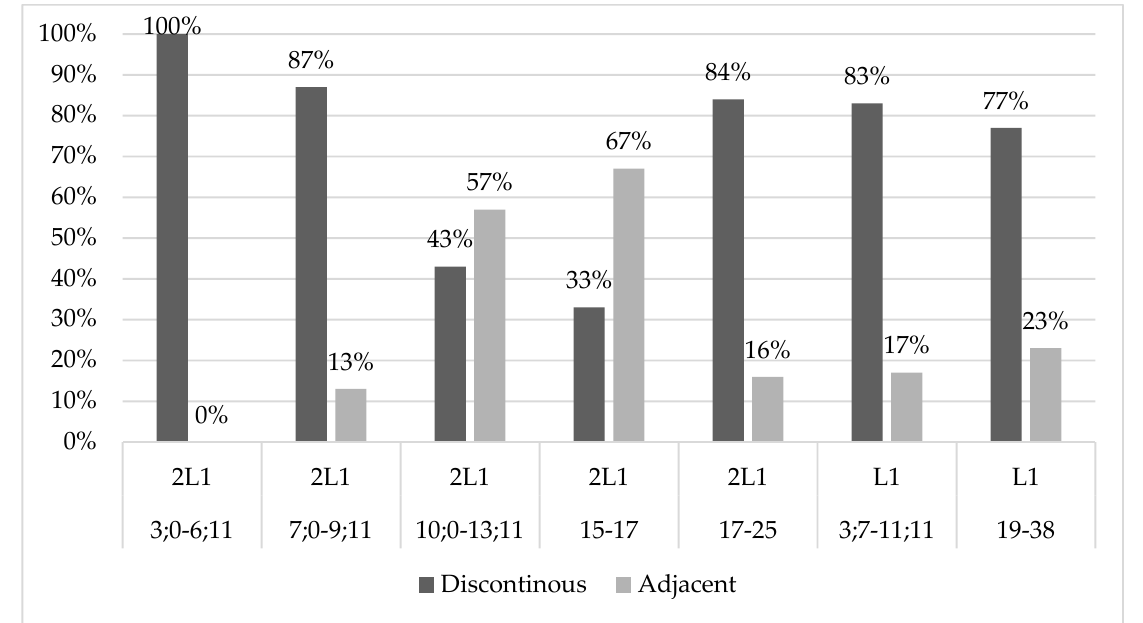
Figure 3. Relative frequency of discontinuous vs. adjacent word order pattern in verb phrases with pronouns in simultaneous bilinguals (2L1) and monolinguals (L1).